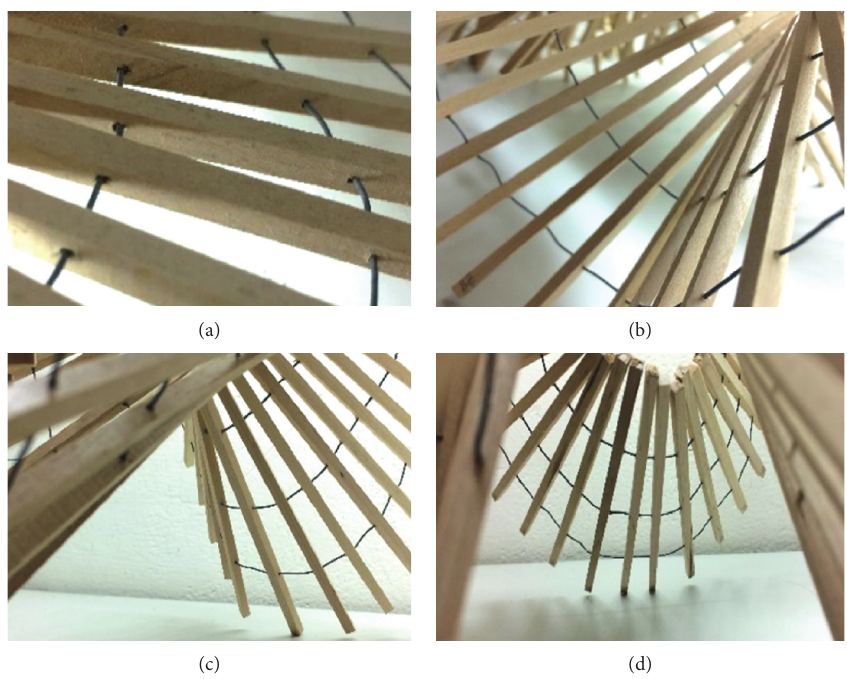
Figure 15: Wire connection of the complex parametric model (source: drawing by the research